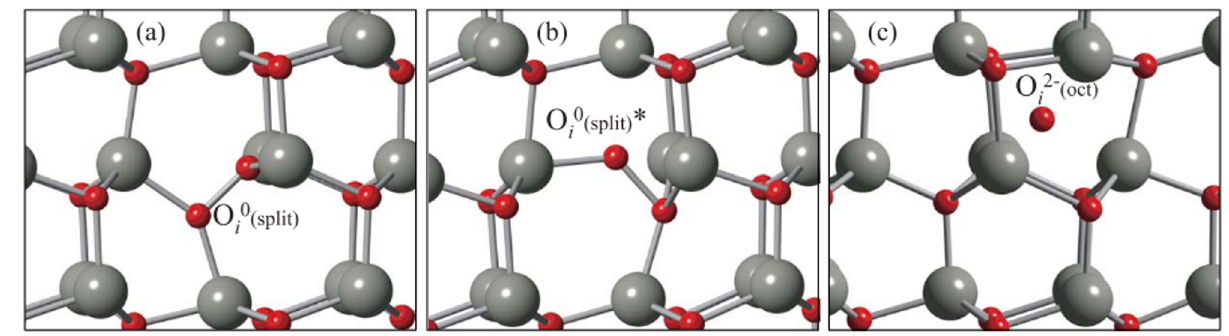
Figure 15: Local atomic geometry of electrically inactive oxygen split interstitial ( a ) in the most stable con fi guration [ O i0 ( split )] and ( b ) in a metastable con fi guration [ O i0 ( split )] *. ( c ) Local atomic geometry of electrically active O i at the octahedral site [ O i2− ( oct )] . Reproduced with permission from American Physical Society [ 263 ]